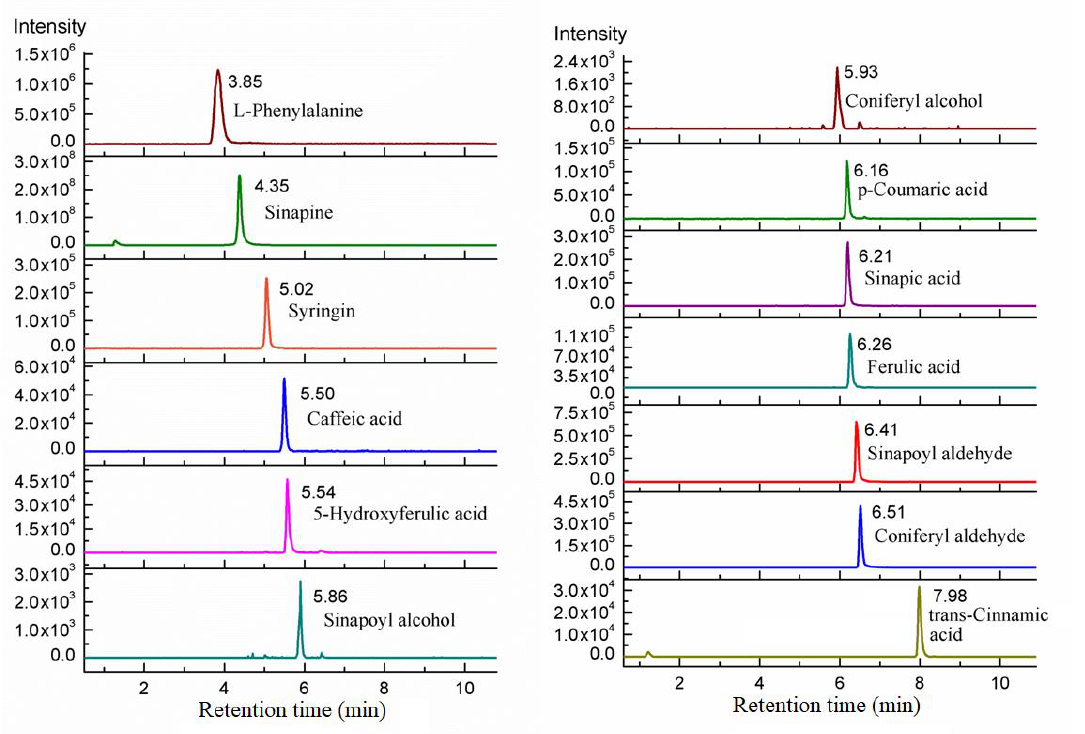
Figure 4. Chromatograms of 13 target compounds in rapeseeds.